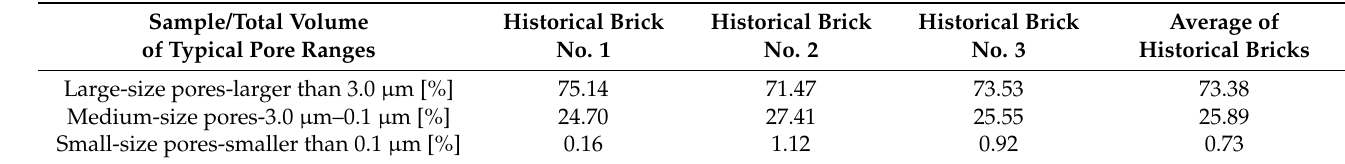
Table 3. The pore size ranges of historical bricks.